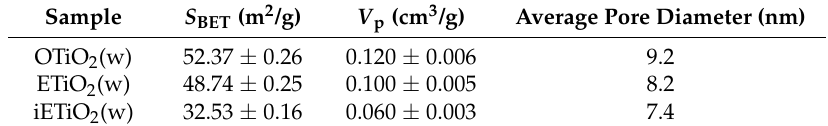
Figure 1. ( a ) FTIR spectra of OTiO 2 (w), ETiO 2 (w), iETiO 2 (w), and imidazoline; ( b ) XRD patterns of OTiO 2 (w), ETiO 2 (w), and iETiO 2 (w); ( c ) Thermogravimetric (TG) analysis curve of iETiO 2 (w). Table 1. Textural and structural properties of the multi ‐ functional carriers.